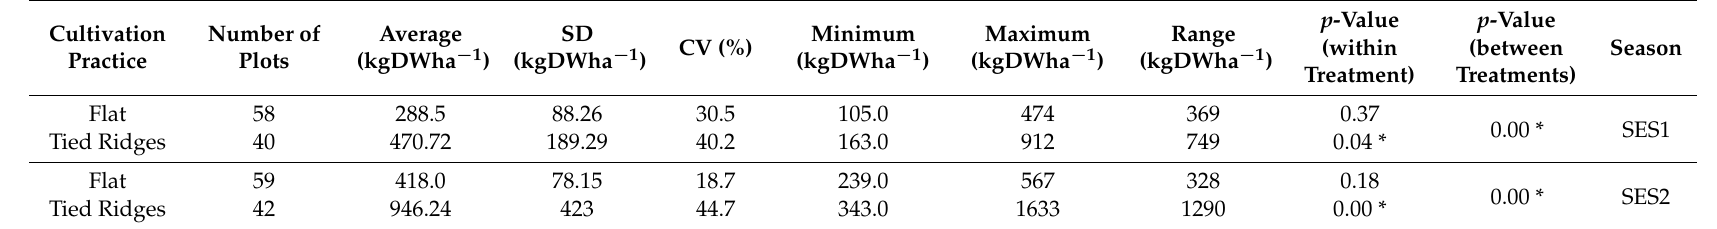
Table 5. Overall comparison of yield variations for flat cultivation and tied